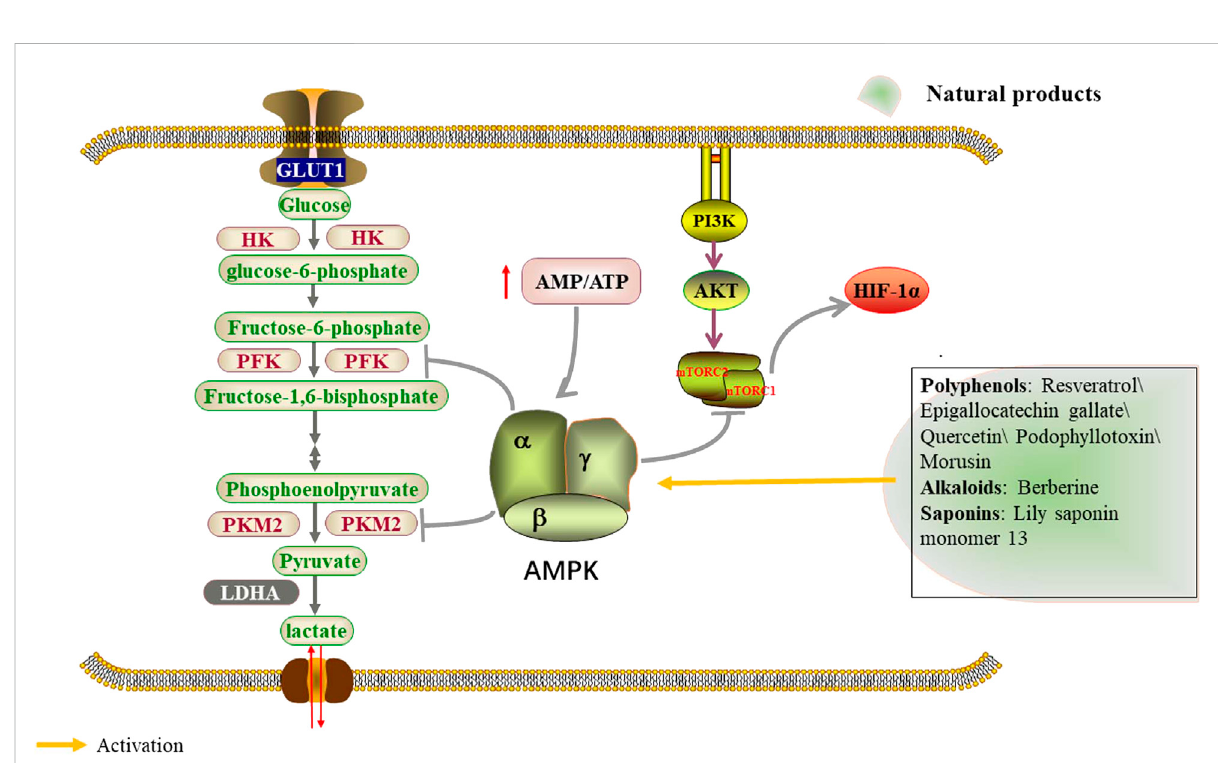
FIGURE 4 Natural products regulate glycolysis through the AMPK signaling